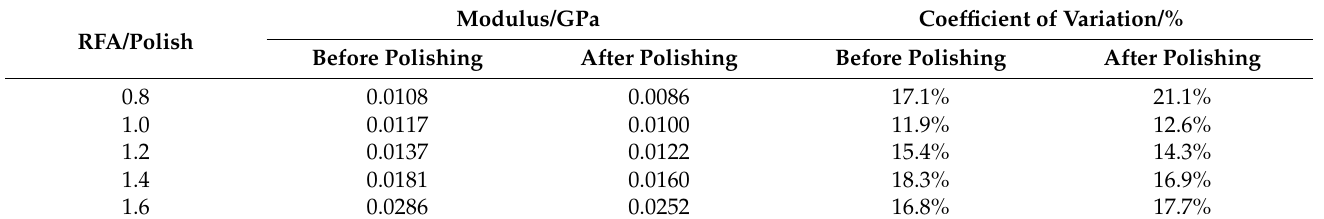
Table 4. Nanoindentation modulus of asphalt mastic specimens before and after polishing.